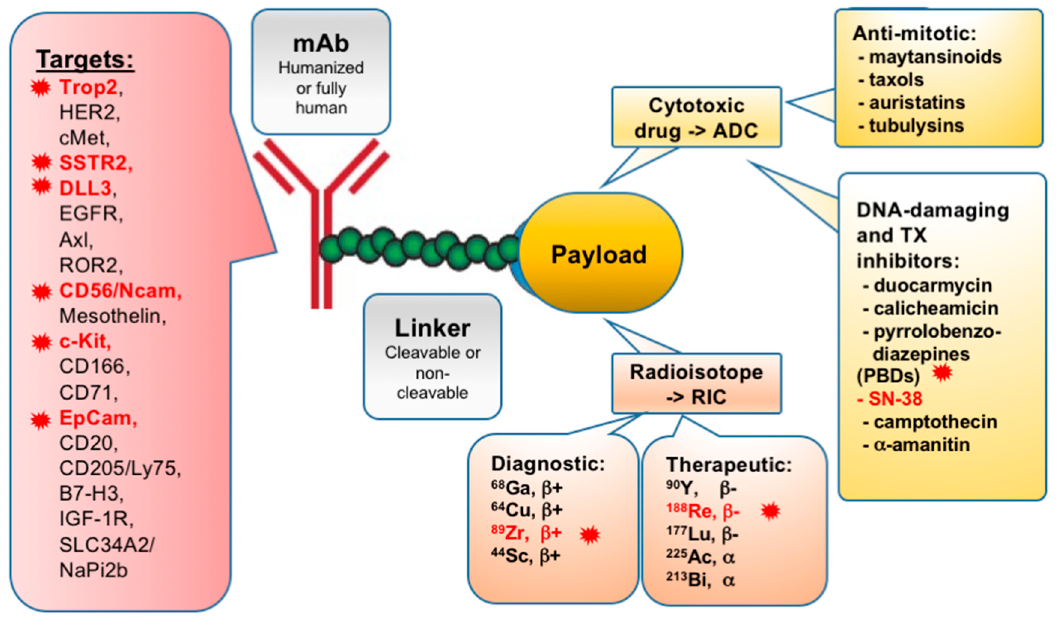
Figure 1. Structure, target antigens in solid tumors, and mechanism of action of antibody-drug conjugates and radioimmunoconjugates. Highlighted in red are the targets, cytotoxic compounds, and radioisotopes assessed in small cell lung cancer (SCLC) trials.